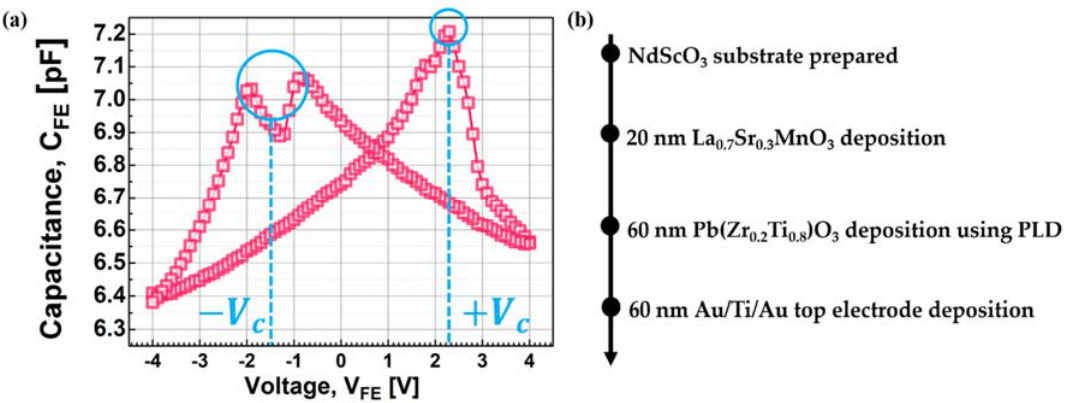
Figure 2. ( a ) Measured capacitance versus voltage of a ferroelectric capacitor. The blue-colored dash lines indicate the approximate positive coercive voltage (i.e., ~ + 2.25 V) and negative coercive voltage (i.e., ~ − 1.5 V). ( b ) Fabrication process flow of a PZT capacitor.